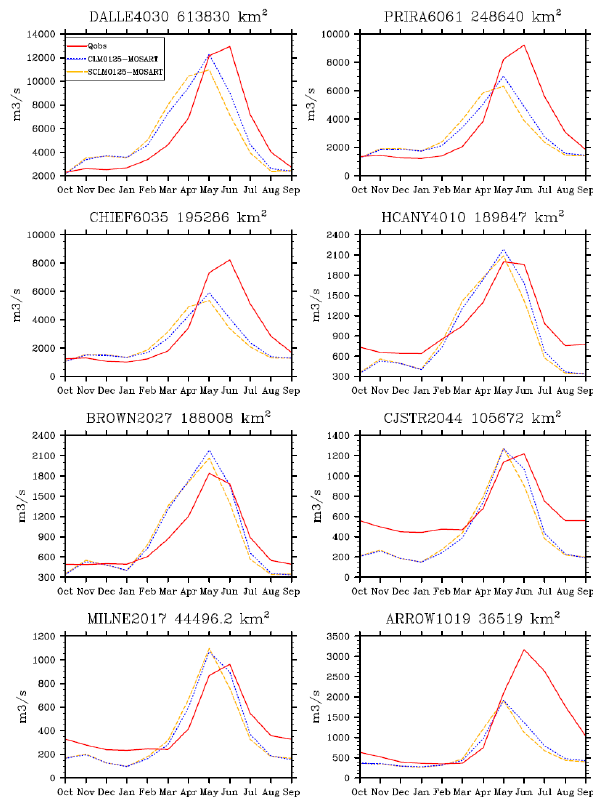
Figure 3. Streamflow from the finest SCLM-MOSART and CLM- MOSART compared to naturalized flow (Qobs) across different spatial